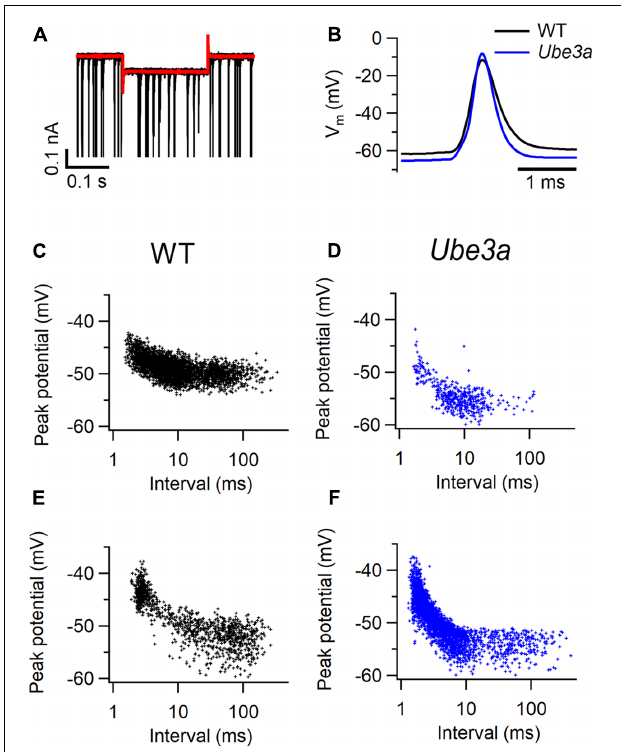
FIGURE 5 | Intrinsic properties of MNTB neurons in Ube3a mice. (A) Representative superimposed action potentials (APs) from a C57BL/6J WT (black) and a Ube3a E113X (blue) mouse, recorded in vivo in the whole-cell configuration. (B) Superimposed average trace (red), and the overlay of 5 original traces with spontaneous activity (black) during a 0.2 s, 10 mV hyperpolarizing step from a holding potential of − 70 mV. (C–F) Relation between most positive potential reached in subthreshold EPSPs and inter-EPSP interval. Data is from two cells from C57BL/6J WT animals (C,E) and two cells from Ube3a E113X animals (D,F) .